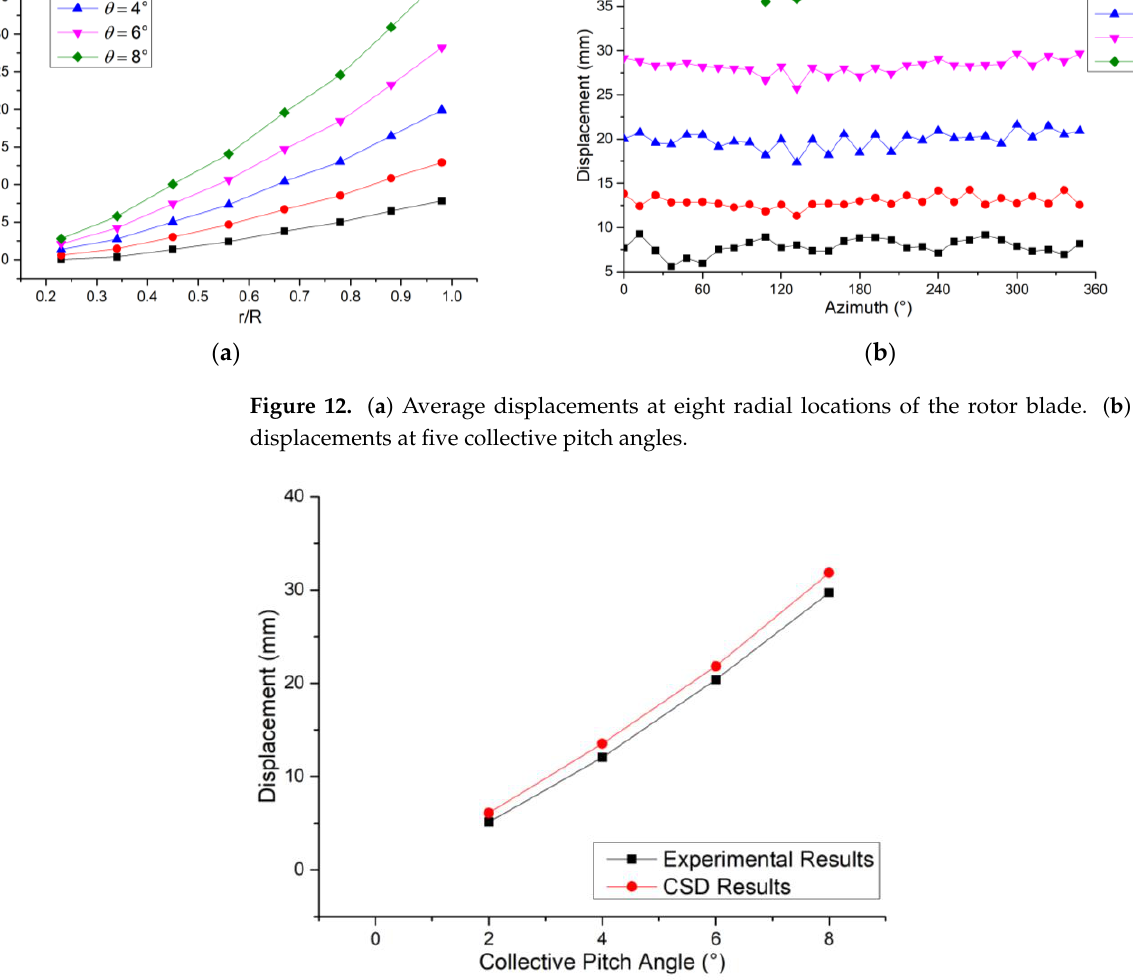
Figure 13. Comparison of the average blade tip displacements between experimental and CSD re- sults.